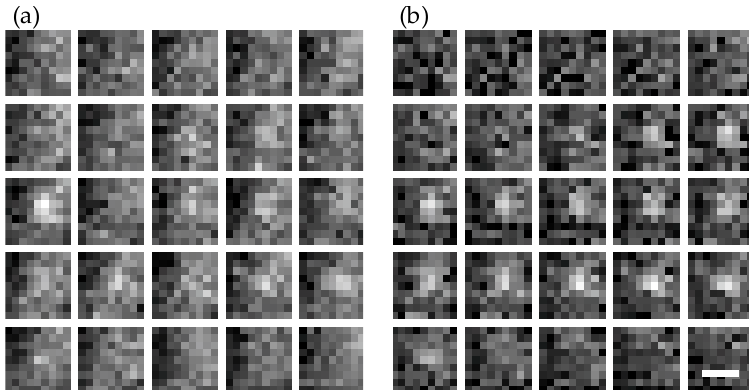
Figure 5. Time trace of a single molecule signal overlaid on a T. atroviride wild-type movie. Shown are images without ( a ) and with ( b ) temporal filtering. Scale bar = 0.8 µm.